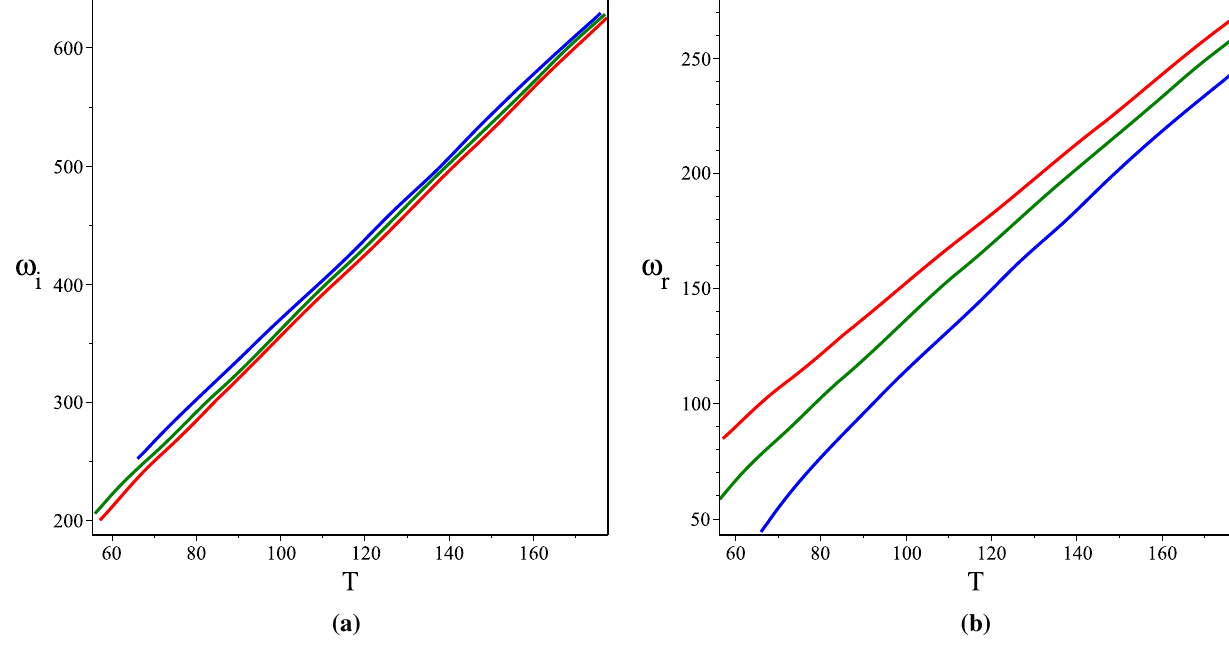
Fig. 11 The behavior of ω i and ω r in terms of T for Q = 5 , 25 , 40 , b = 1 , l =